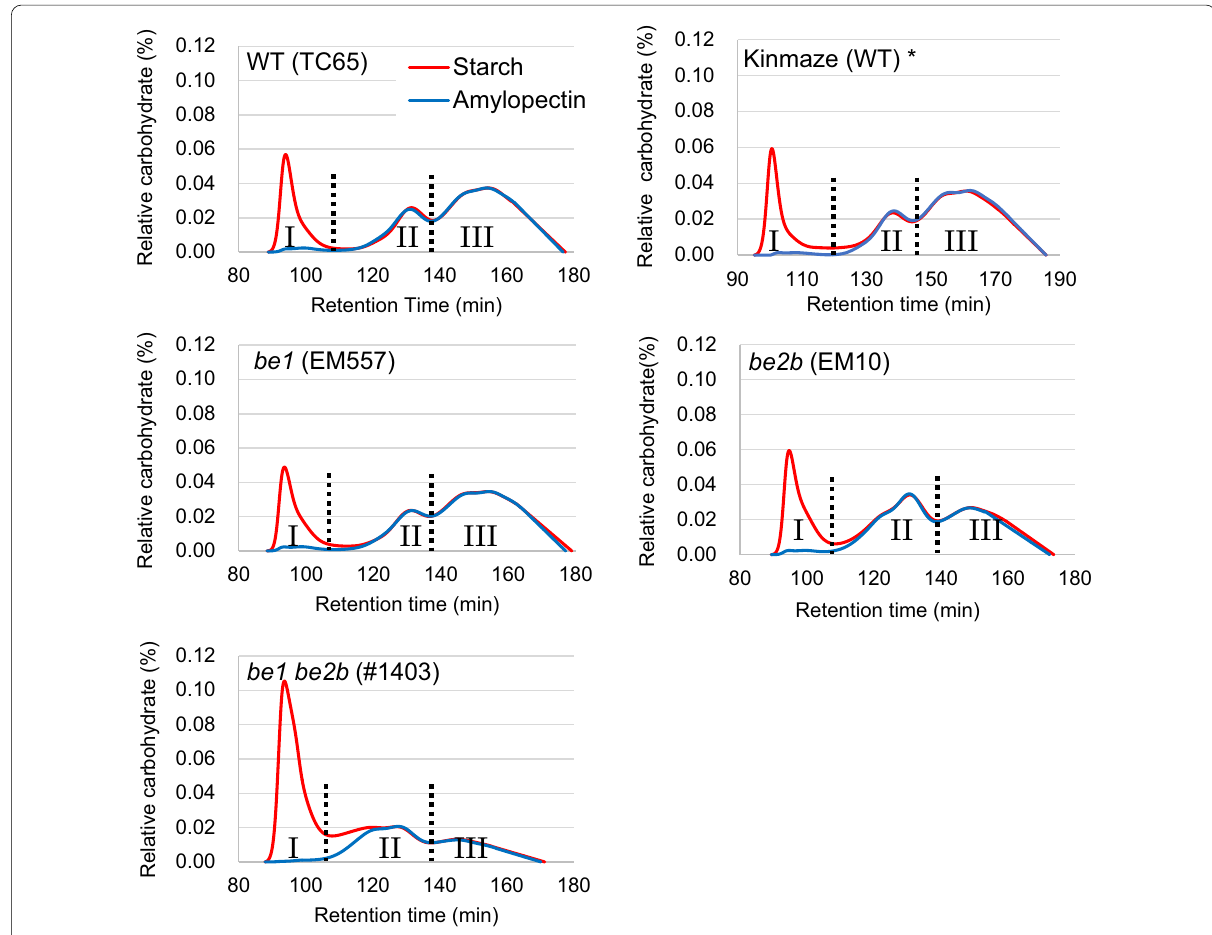
Fig. 2 Elution profiles of isoamylase-treated debranched starch and amylopectin analyzed by gel filtration chromatography (ToyoPearl HW55S-50S 3). Fraction I contains amylose or an extra-long chain of amylopectin. Fraction II contains long amylopectin chains. Fraction III × contains short amylopectin chains. Red lines indicate the patterns obtained from starch, and blue lines indicate the patterns obtained from purified amylopectin. *Differences in retention time (RT) in Kinmaze were due to the different lot of the column. Data was obtained from Miura et al.